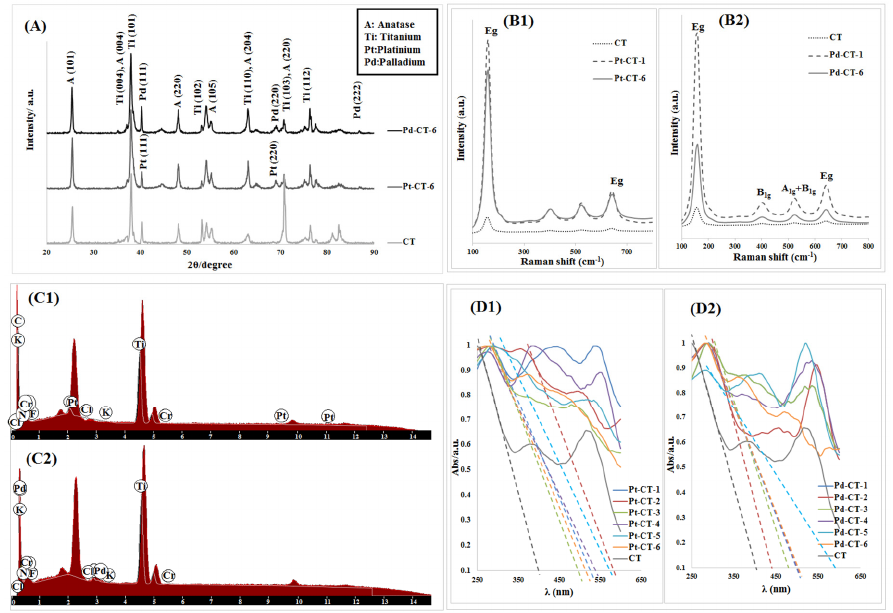
Figure 3. XRD patterns of CT, Pt-CT-6 and Pd-CT-6 ( A ); comparison of Raman spectrum of CT, Pt-CT-1 and Pt-CT-6 ( B1 ), and CT, Pd-CT-1 and Pd-CT-6 ( B2 ), EDX spectrum of Pt-CT-6 ( C1 ) and Pd-CT-6 ( C2 ), and UV-Vis spectrum of Pt-CT-6 ( D1 ) and Pd-CT-6 ( D2 ) electrodes.